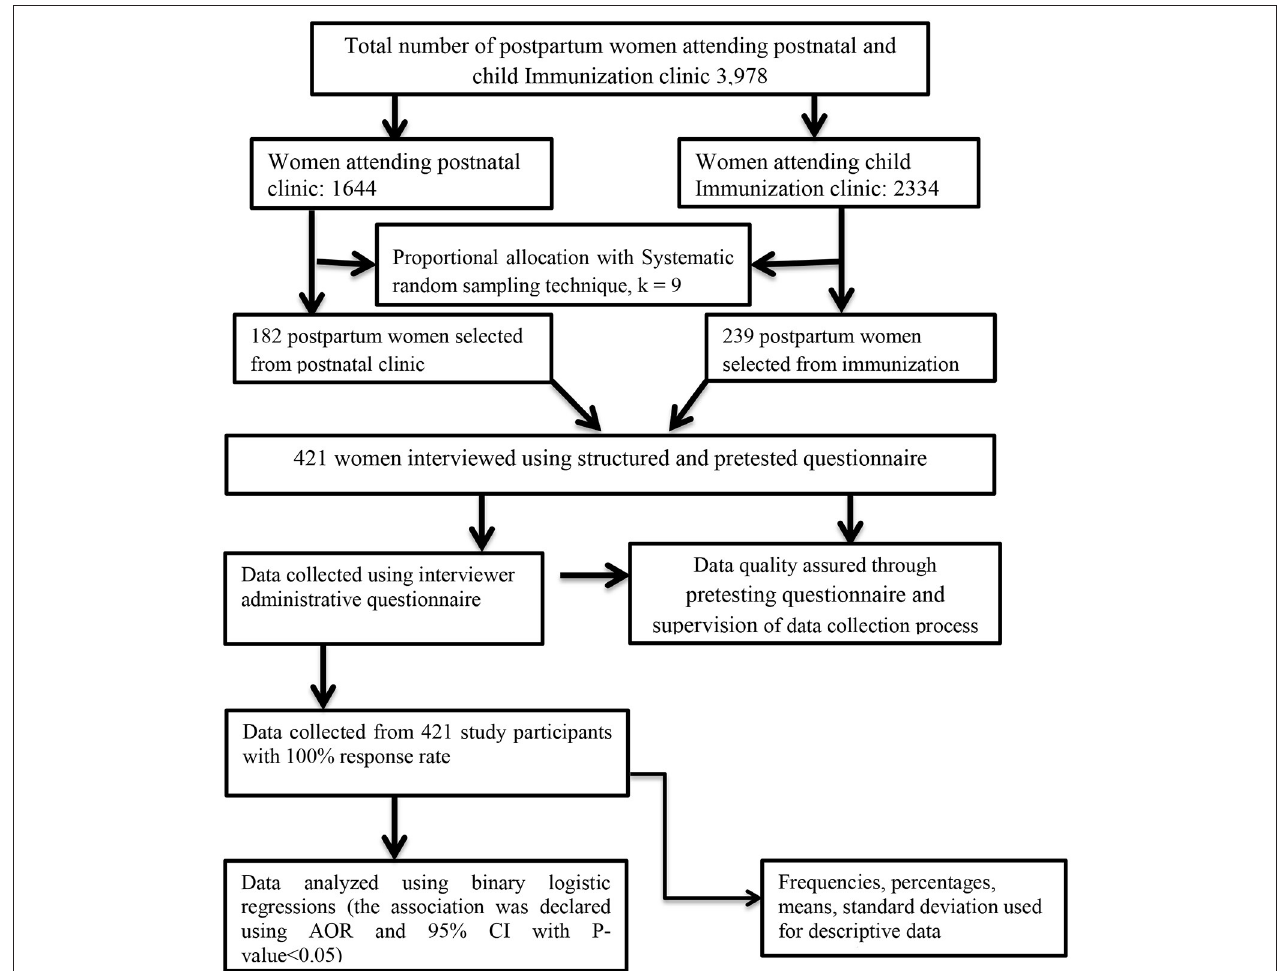
FIGURE 1 | Flow chart of materials and